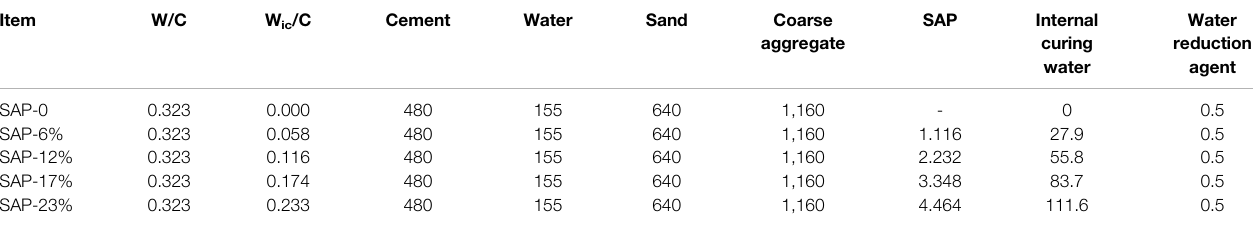
TABLE 1 | The mixing proportions of various SAP concretes (kg/m 3 ).